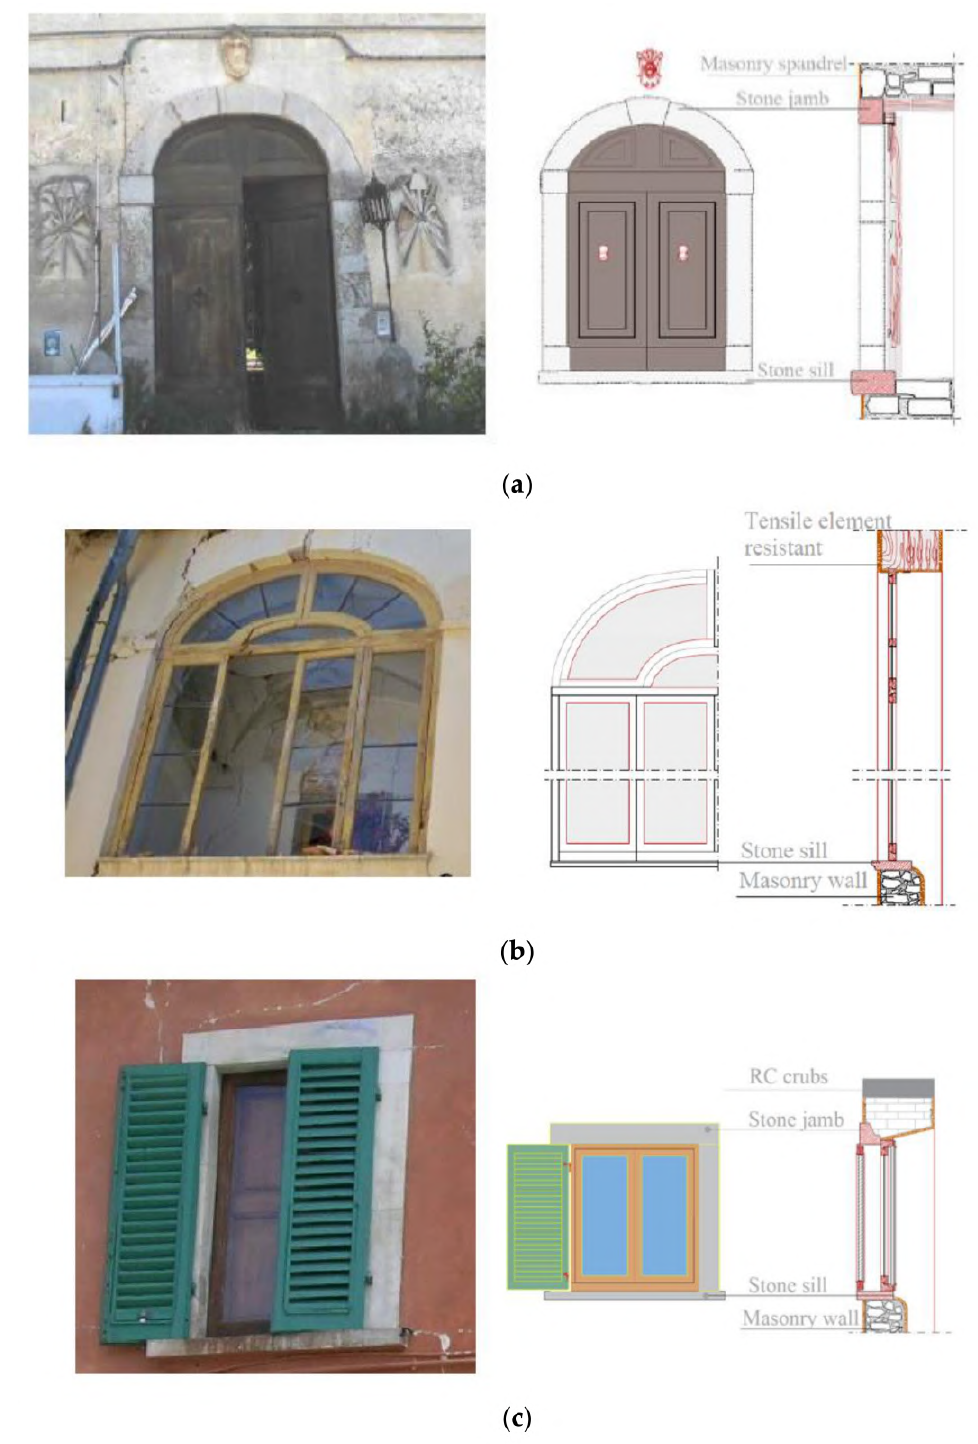
Figure 10. Views of window typologies and the relative construction details detected in L’Aquila: ( a ) opening without tension-resistant elements; ( b ) opening with a tension-resistant element; ( c ) open- ing with ring